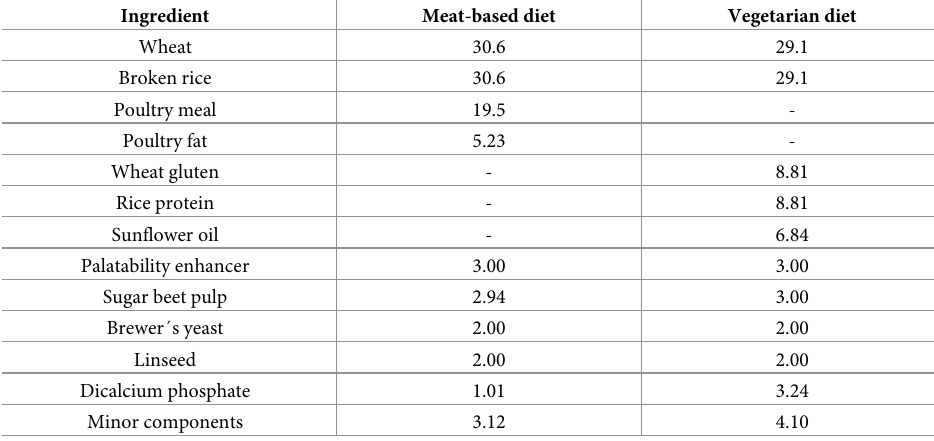
Table 1. Ingredient composition of the meat-based diet and vegetarian diet (% as fresh